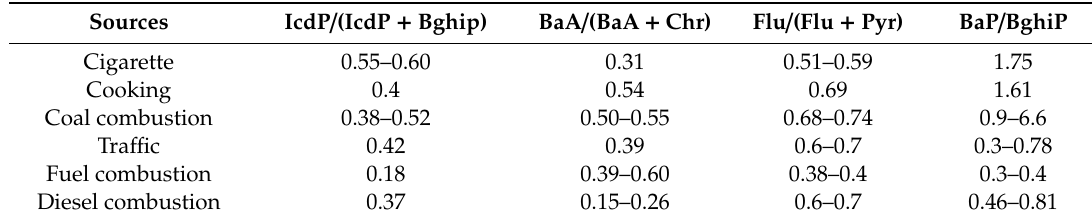
Table 1. Values of the diagnostic ratios (DR) method from di ff erent polycyclic aromatic hydrocarbon (PAH) resources.